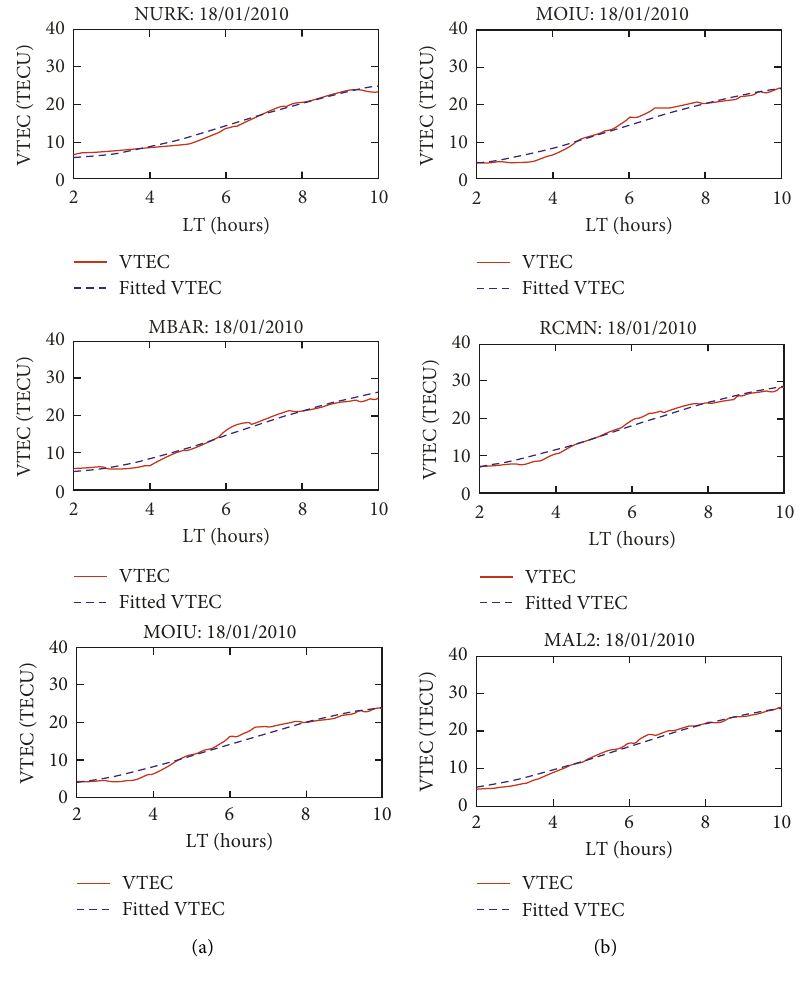
Figure 11: VTEC and fitted VTEC against local time (LT) across (a) NURK-MBAR-MOIU and (b) MOIU-RCMN-MAL2 GPS array on 18 th January 2010.